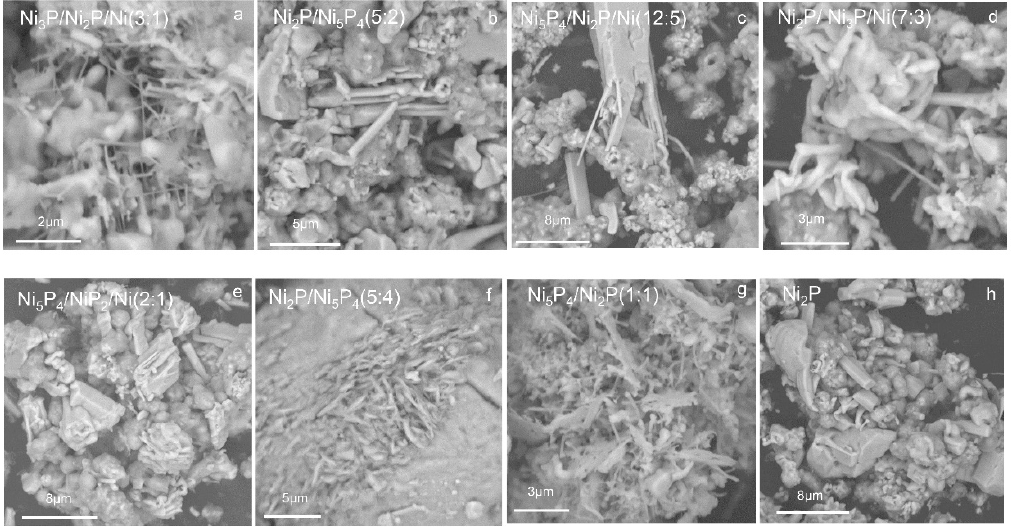
Figure 2. SEM images of various Ni/P ratios and single-phase Ni 2 P. ( a – g ) SEM images of Ni/P